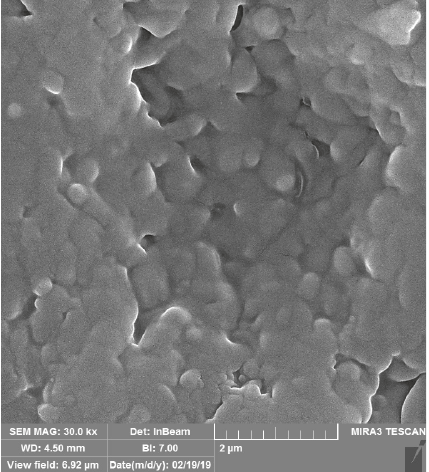
Figure 11: SEM fractograph of 10 wt. % MMT